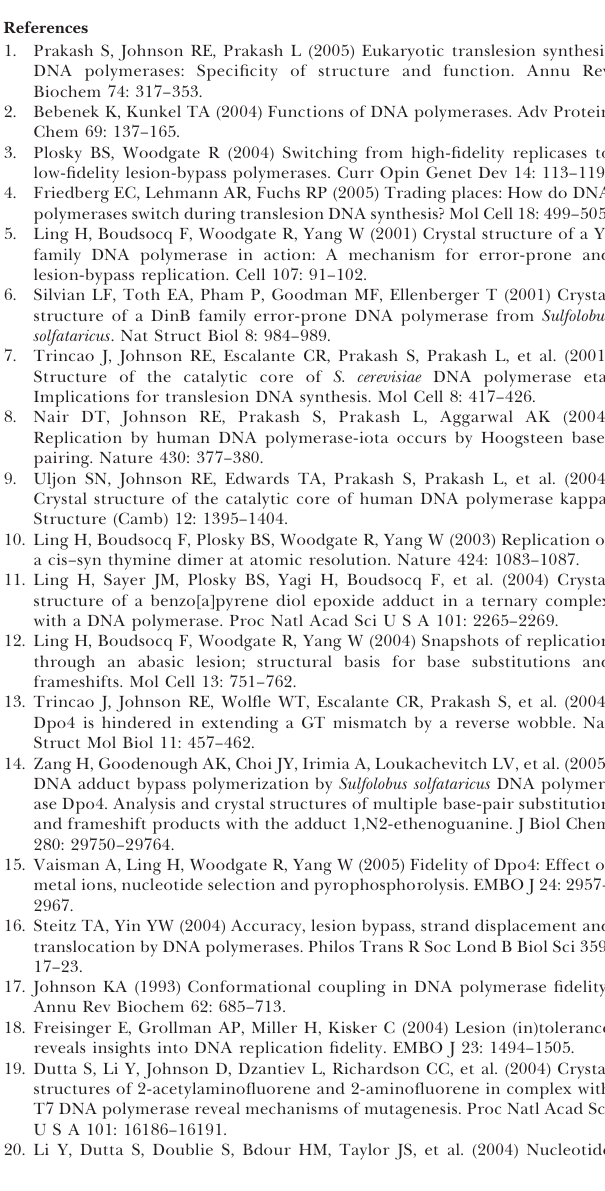
Figure S5. Base-Pairing Alignments of 8-oxo-Guanine (oxoG) (A) Hydrogen-bonding alignments in oxoG (anti) (cid:2) C (anti) pair. (B) Hydrogen-bonding alignments in oxoG( syn ) (cid:2) A (anti) pair. Protocol S1. Experimental Procedures: Full Description of the Twinning Problem for Preinsertion Binary Complexes Found at DOI: 10.1371/journal.pbio.0040011.sd001 (28